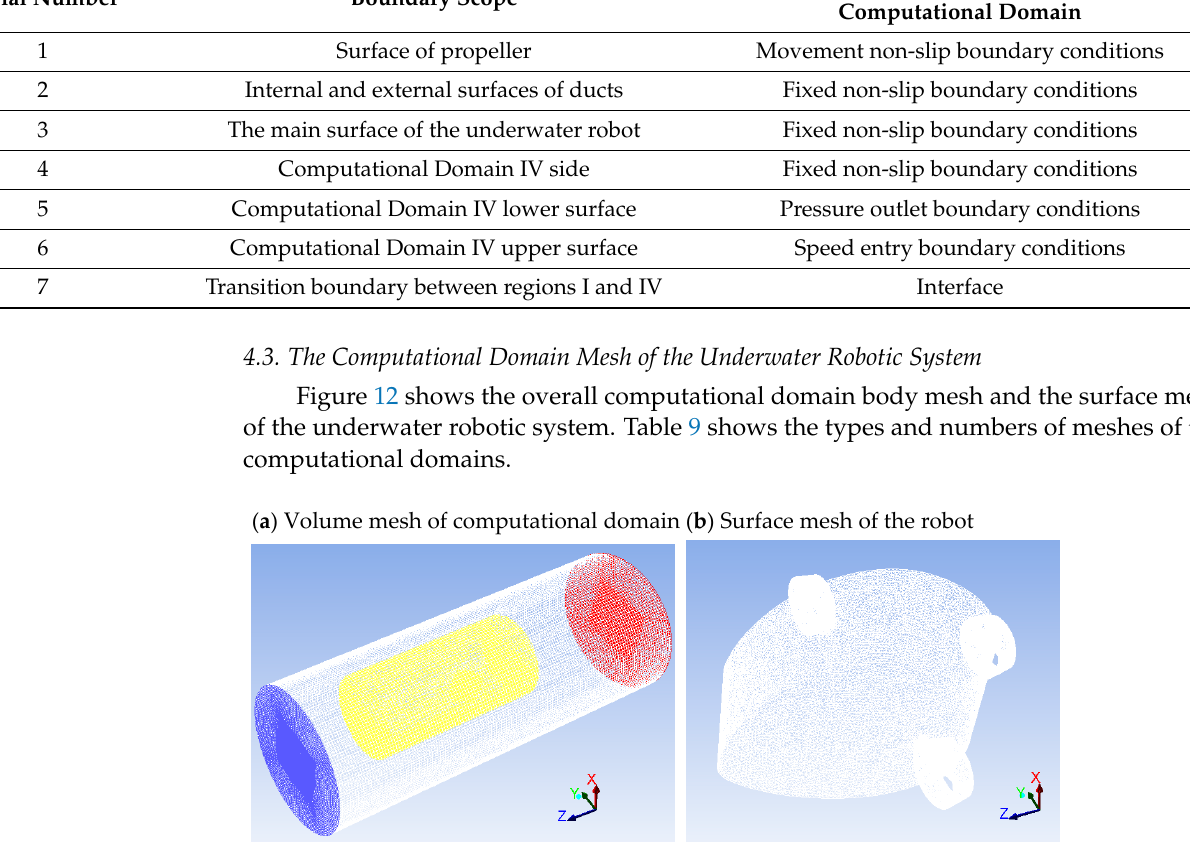
Figure 11. Computational domains of the underwater robot system. Table 8. Boundary conditions of the underwater robot system.